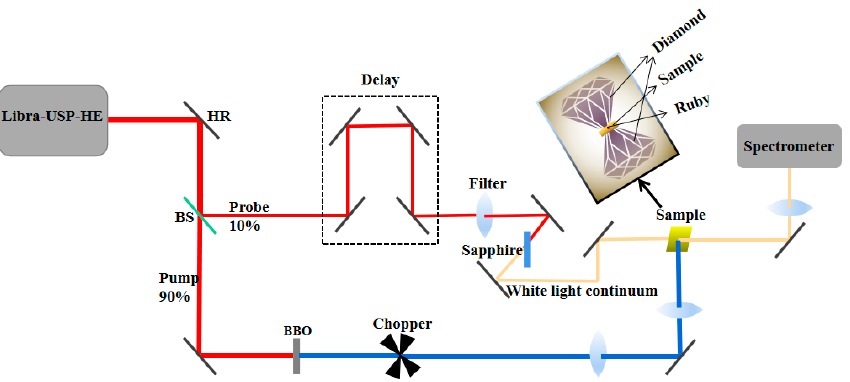
Figure 1. Femtosecond transient absorption spectroscopy under pressure. (HR: high reflector; BS: beam splitter; BBO: barium metaborate crystal.)